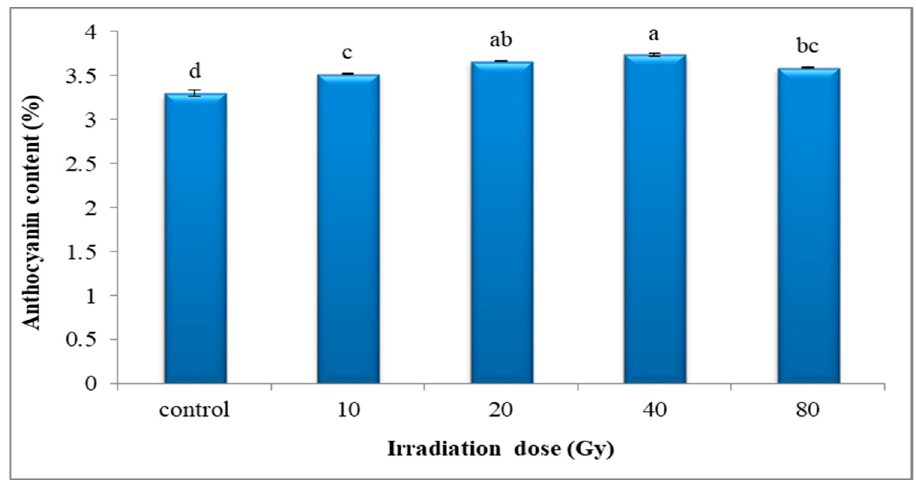
Figure 4. The content of anthocyanin (%) affected by different doses of gamma-rays of red radish roots. Findings are means ± standard deviations (n = 3). Different letters point to significant variations at p ≤ 0.05, and bars indicate standard deviations.